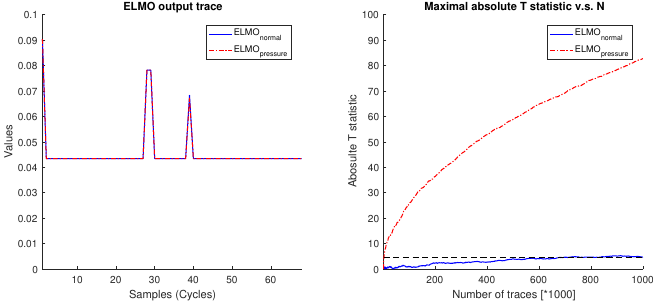
Figure 13: ELMO evaluation on the LSR-based 2-share